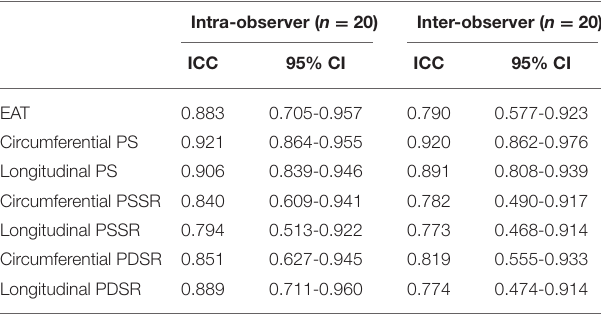
TABLE 7 | Comparison of inter- and intra-observer variability among epicardial adipose tissue and RV peak strain